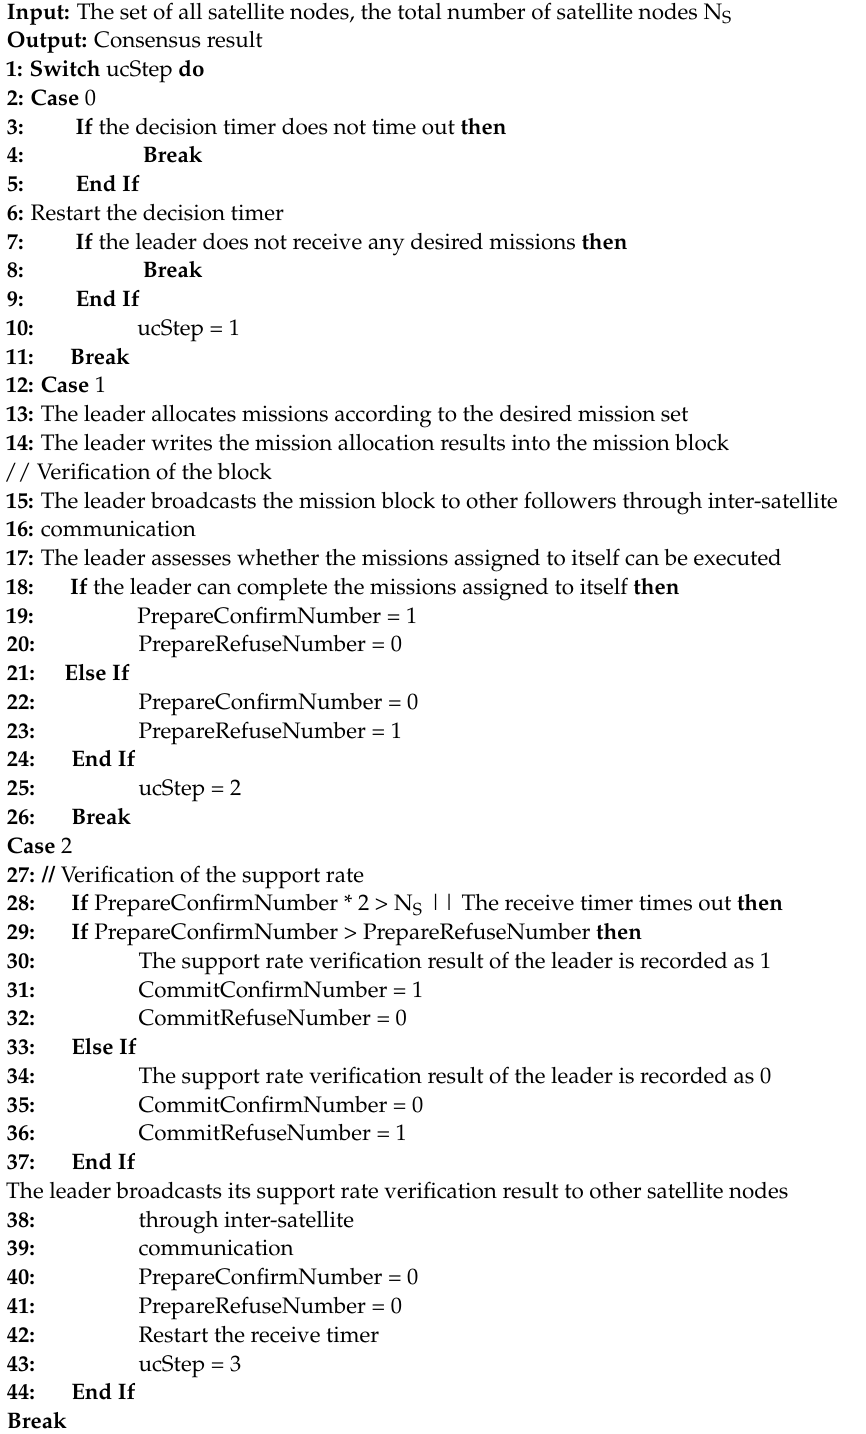
Algorithm 4. The leader decision behavior of the modified PBFT